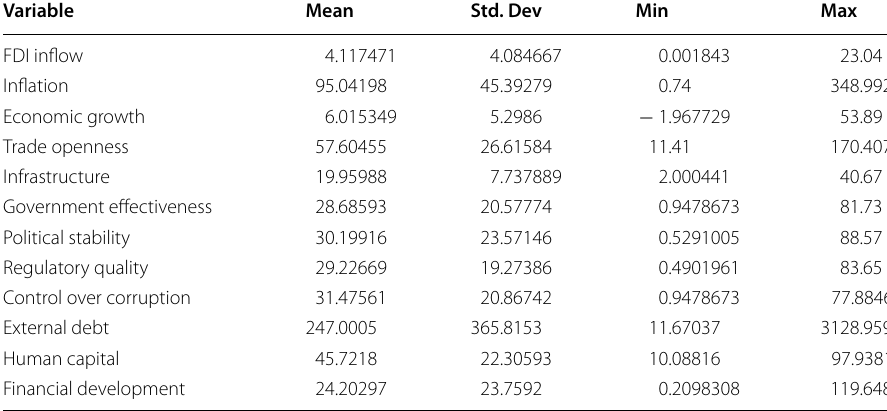
Table 1 Summary of descriptive